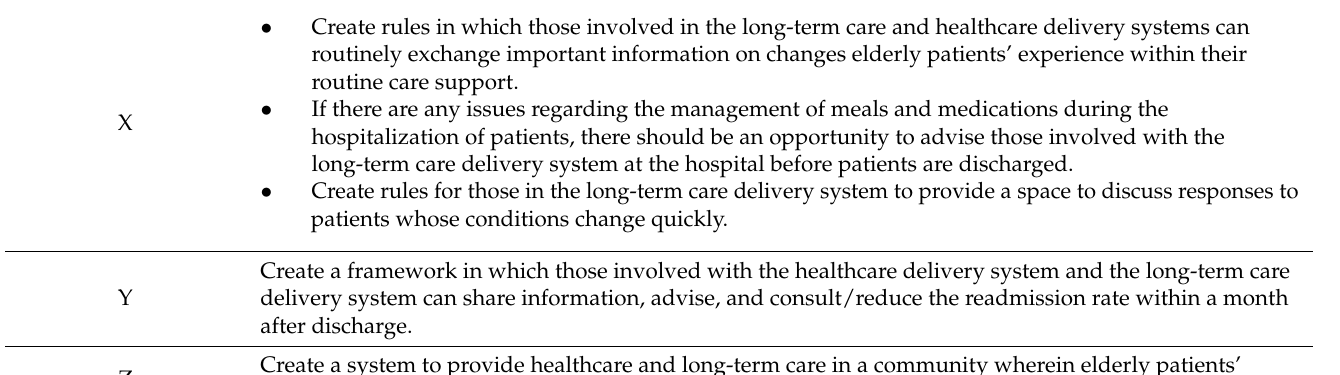
Table 1. Results of the XYZ analysis.